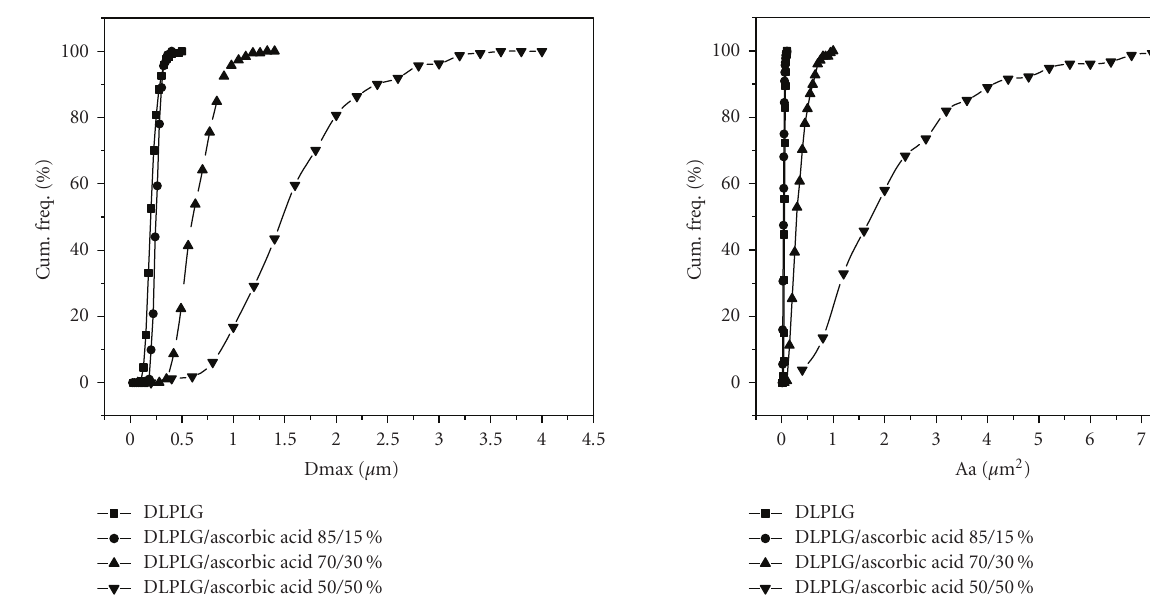
size is 0.67 µ m (Figure 6), which indicates that the unifor- mity is decreased and size is increased. The mean value of the area section is 0.41 µ m 2 (Figure 7) and of the perimeter form factor is 0.77 (Figure 8). For particles DLPLG/ascorbic acid 50/50%, minimum Dmax is 0.28 µ m and